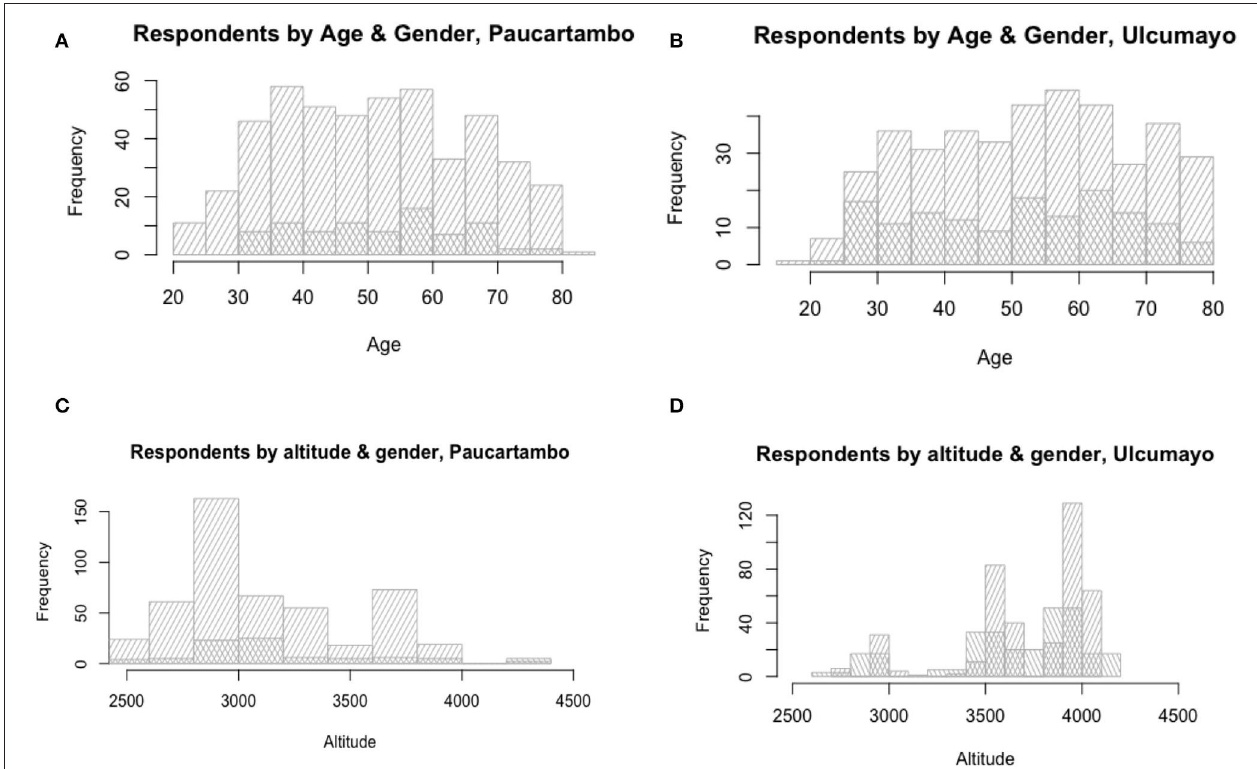
FIGURE 1 | Frequency histograms of respondents by age and gender in Paucartambo (A) and Ulcumayo (B) and of respondents by altitude for Paucartambo (C) and Ulcumayo (D) ; males, forward slashed bars; females, hatched bars.